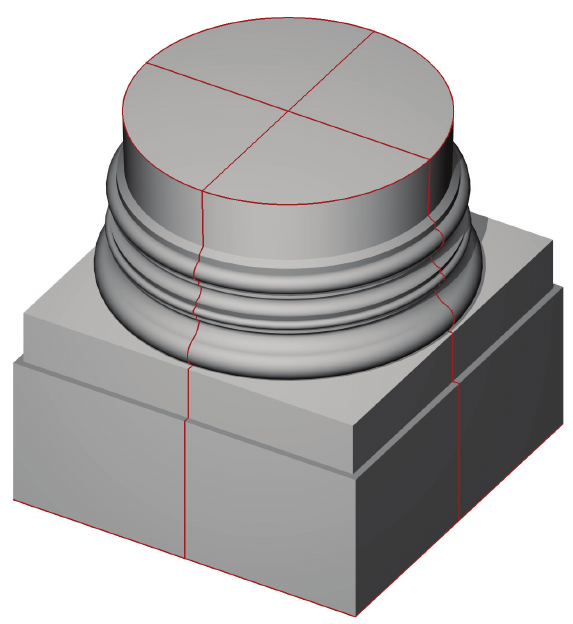
Figure 10. The San Carlo column base. 3d model created by extrusion of section on a circular path and a square